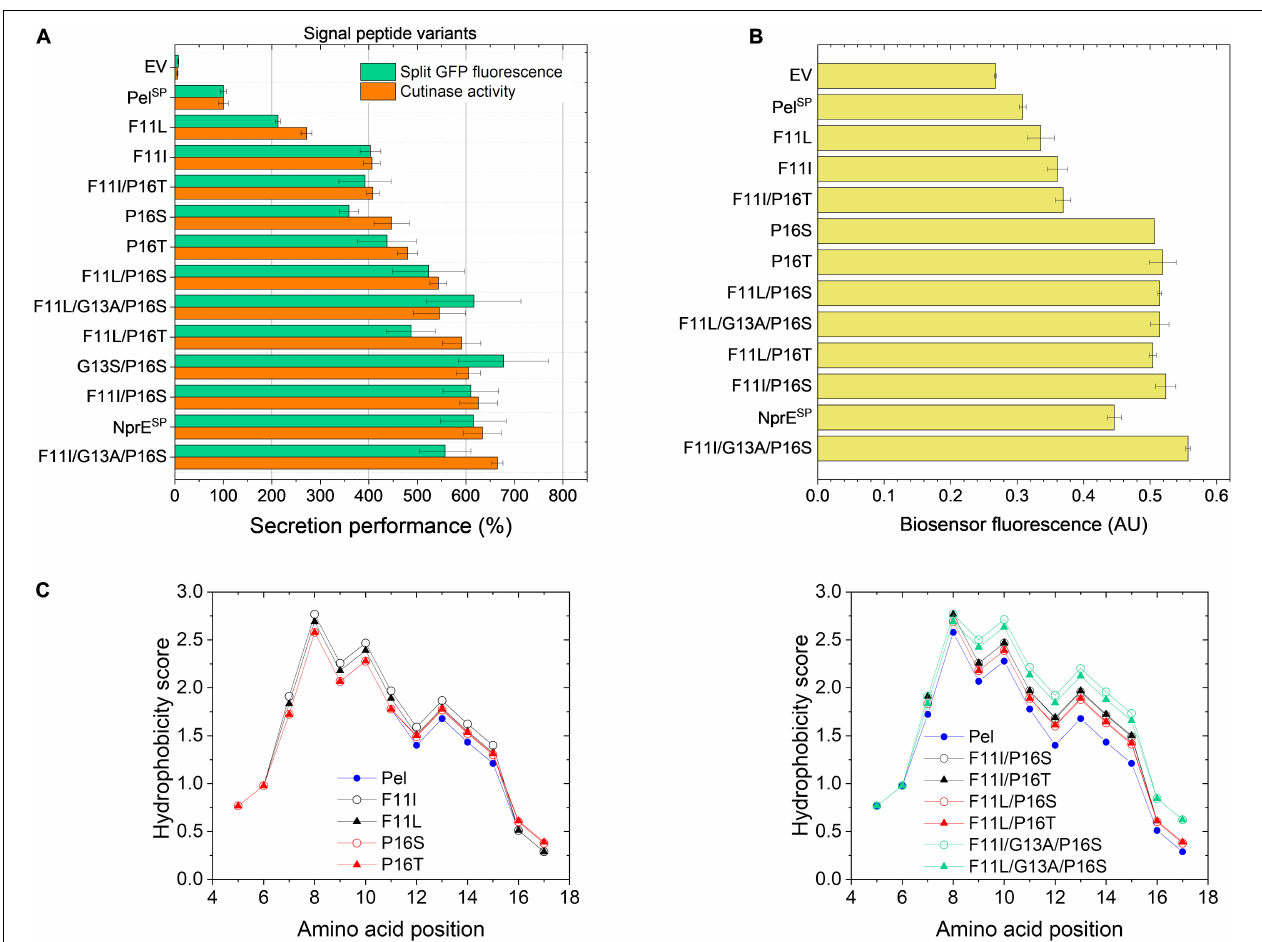
FIGURE 4 | Secretion performance and hydrophobicity of Pel SP variants created by site-directed mutagenesis. C. glutamicum K9 biosensor cells were transformed with pPBEx2-Pel-cutinase-GFP11 mutant plasmid encoding the different Pel SP variants as indicated. The recombinant strains were grown in CGXII medium containing 1% (v/v) glucose in a BioLector for 24 h at 30 ◦ C, 1,200 rpm and 85% relative humidity, along with the control strains harboring pPBEx2 (EV), pPBEx2-NprE-cutinase-GFP11 (NprE SP ) and pPBEx2-Pel-cutinase-GFP11 (Pel SP ). Four hours after inoculation, IPTG was added to the cultures to a final concentration of 250 µ M. (A) At the end of the cultivation (24 h), the secretion performance was assessed by measuring the split GFP fluorescence (green bars) and the cutinase activity (orange bars), respectively. The secretion performance of the different variants is shown relative to that of the Pel SP control (100%) and is ranked according to the cutinase activity in ascending order. (B) The corresponding specific fluorescence at the end of the cultivation of the biosensor cells expressing the different variants is indicated. (C) Hydropathy plots showing the influence of the introduced single (left panel) and multiple mutations (right panel) as indicated on the overall hydrophobicity of the Pel SP . The data were obtained by ProtScale (https://web.expasy.org) and using the hydropathy scale according to Kyte and Doolittle